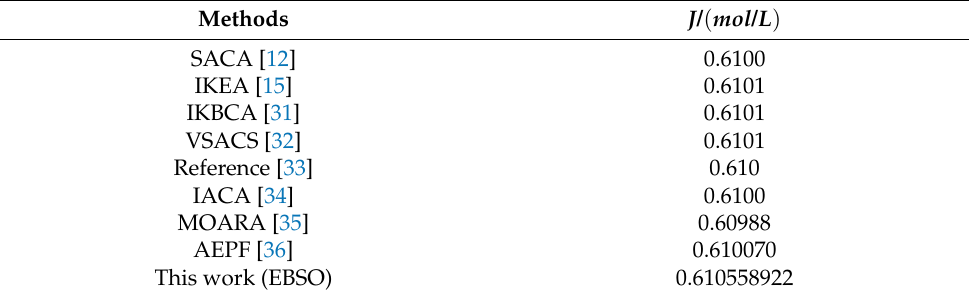
Table 5. Comparison of methods of batch reactor ( N =